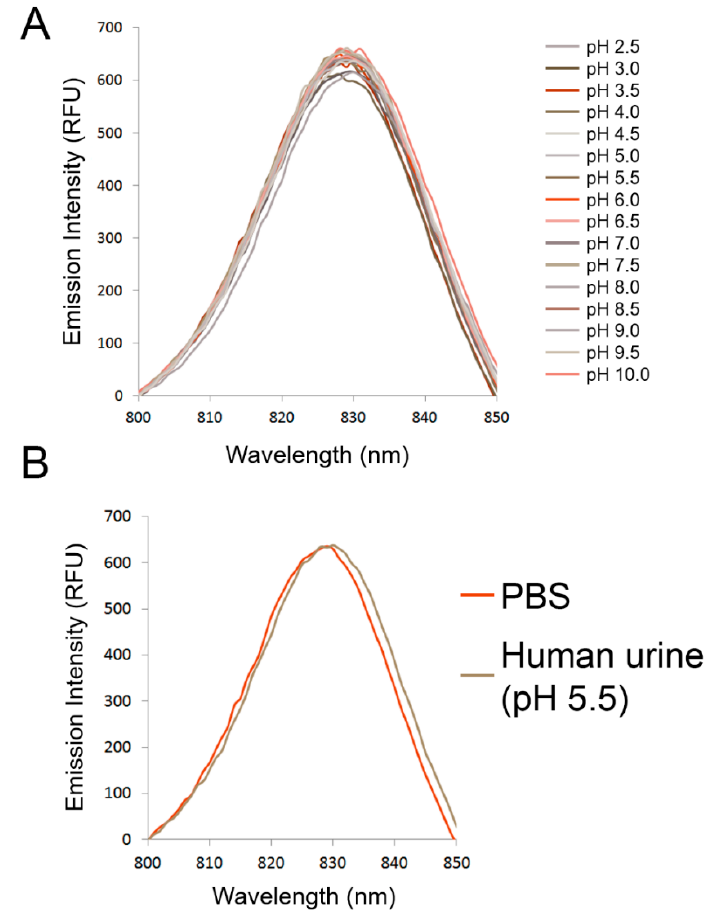
Figure 6. Sensitivity of UreterGlow-45 emission spectra in different pH buffers. ( A ) UreterGlow-11 (1 µ M) was excited at 800 nm while dissolved in sodium acetate buffered saline at various pH levels, and the emission spectra were characterized. ( B ) UreterGlow-11 (1 µ M) was excited at 800 nm while dissolved in PBS (pH 7.4) or human urine (pH 5.5), and the emission spectra were characterized.